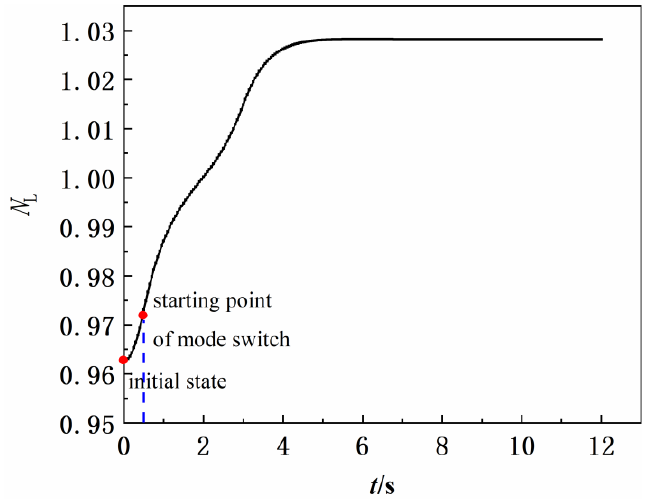
Figure 12. Change curve of low-pressure rotor speed of working-mode switching from double bypass to single bypass at H = 0 km, Ma = 0.